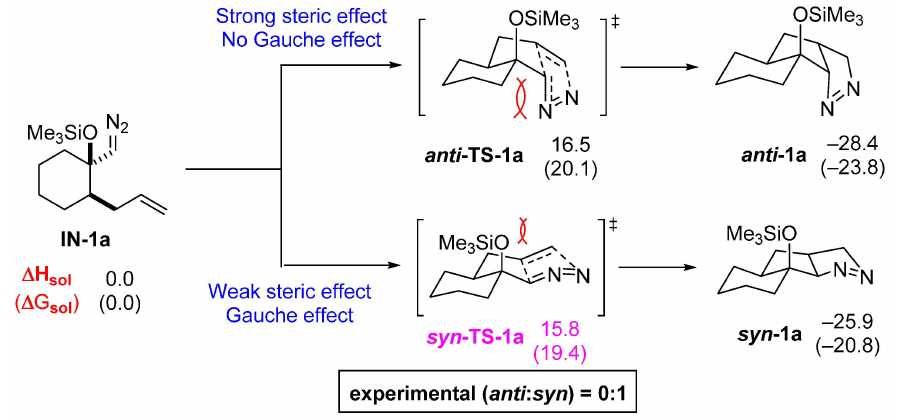
Figure 4. Energy profiles of pyrazoline formation with high syn -diastereoselectivity (in kcal/mol).